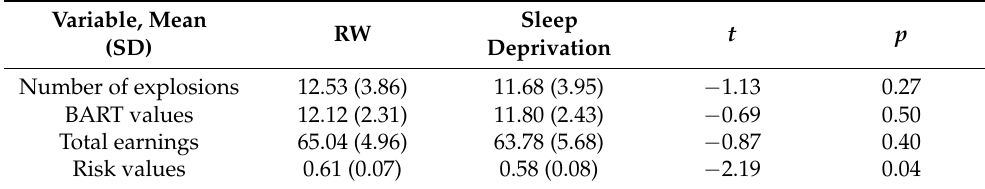
Table 1. Basic statistics of risky decision performance in both RW and sleep